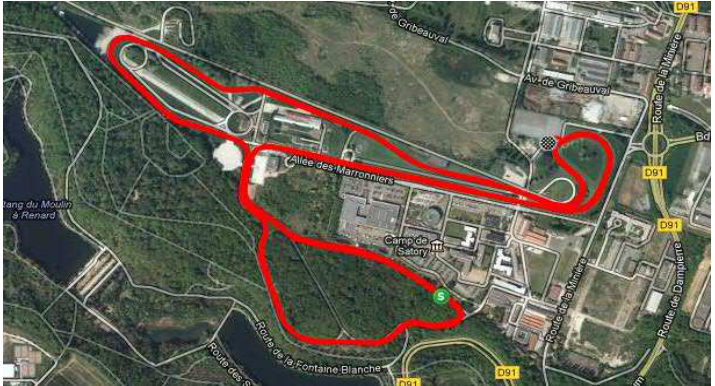
Figure 4. Aerial view of the Satory test